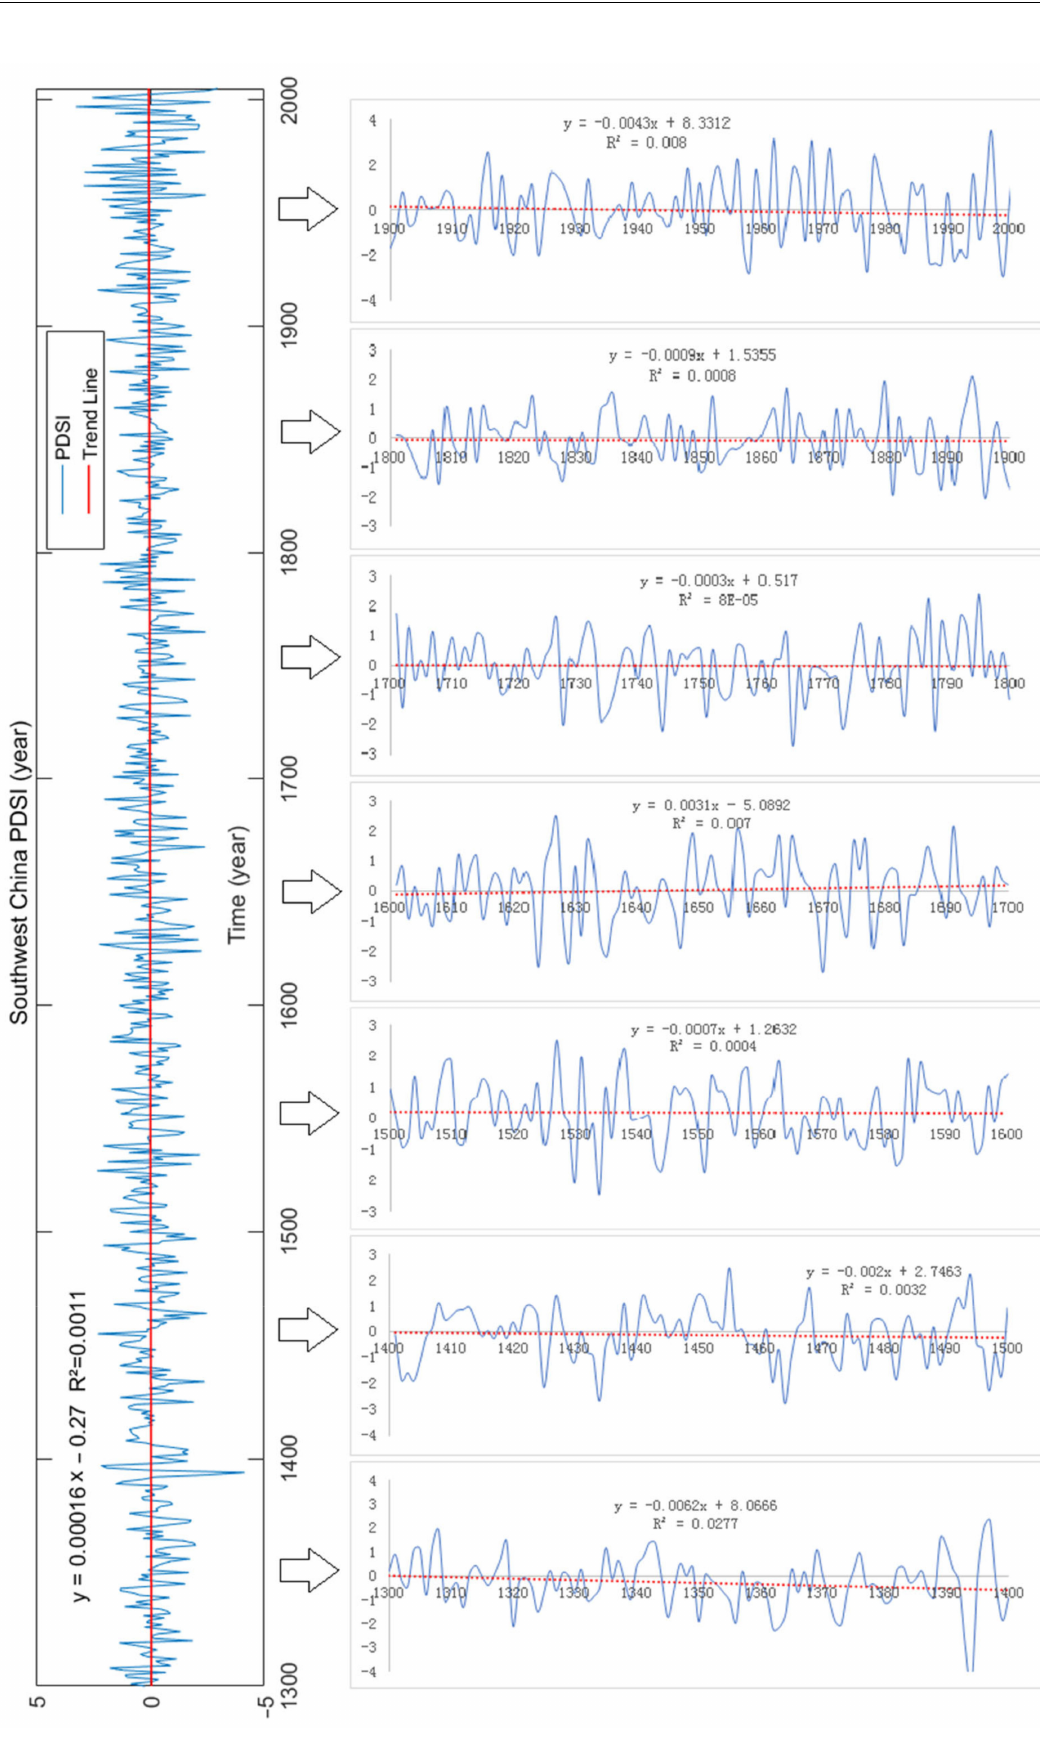
Figure 3. Variation trend of the PDSI time series from 1300 to 2005 in the study